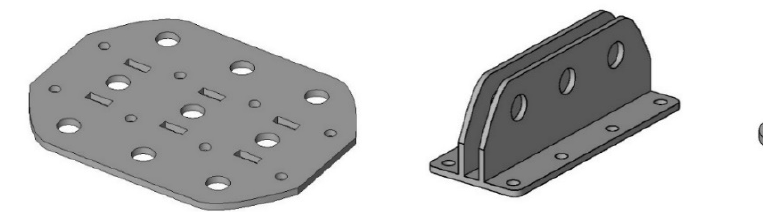
Figure 9. Components based in a face-based